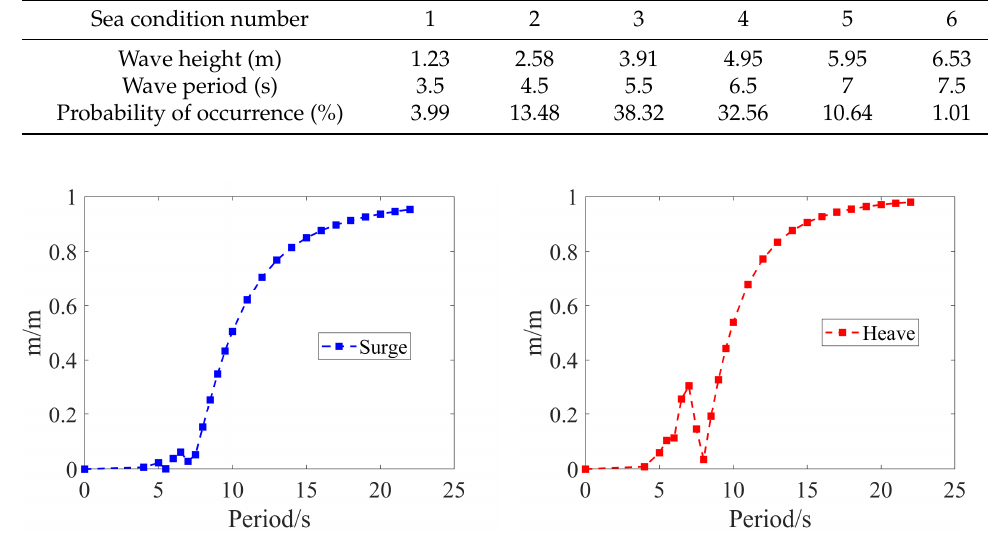
Table 2. Wave conditions.